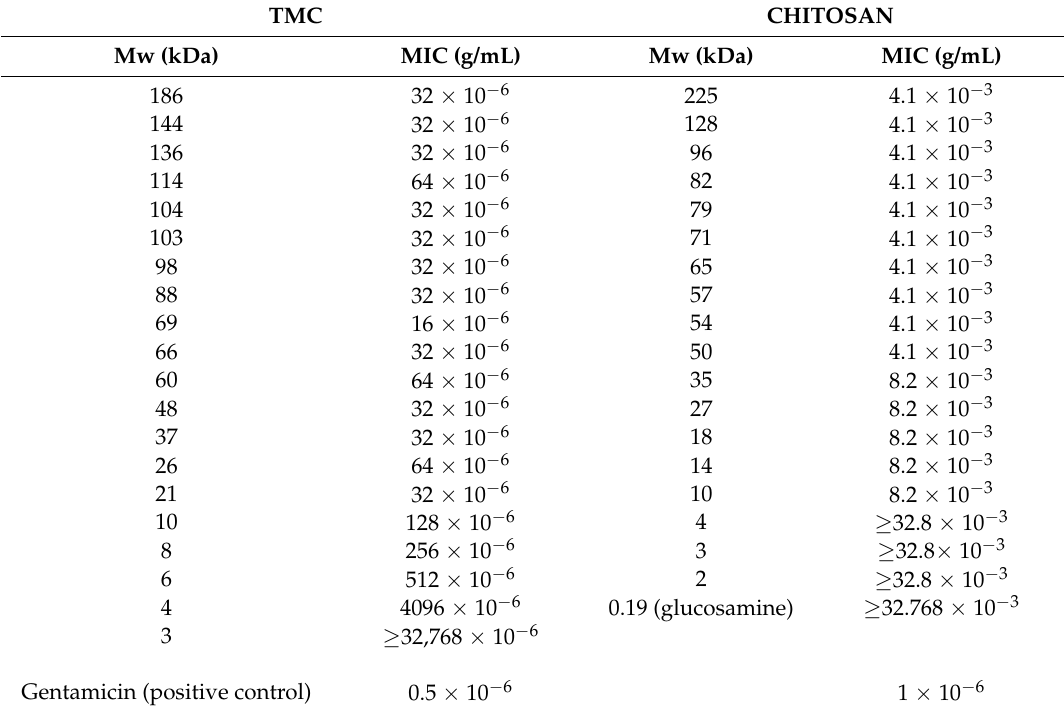
Table 2. Table showing the MIC value for the different Mw for TMC and chitosan.